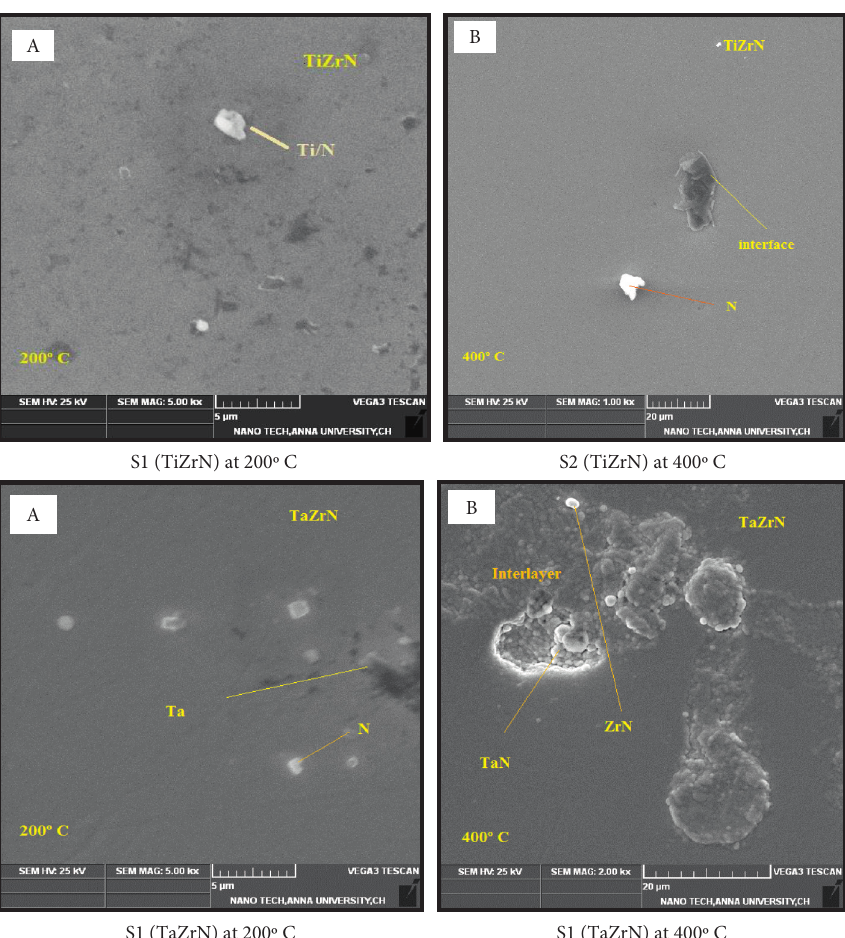
Figure 2: Cross-section SEM image of TiZrN/TaZrN films with different temperatures: (a) S1 (TiZrN) at 200 ° C, (b) S2 (TiZrN) at 400 ° C, (c) S1 (TaZrN) at 200 ° C, and (d) S1 (TaZrN) at 400 °